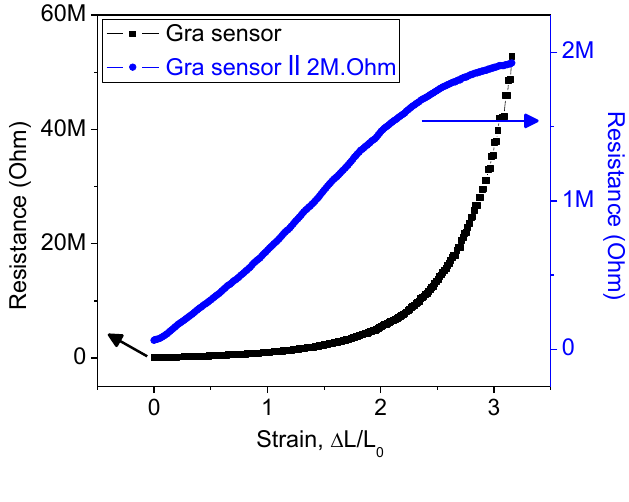
Figure 7. Linearization: response curves for graphite sensor with (blue) and without (black) a 2 MΩ parallel